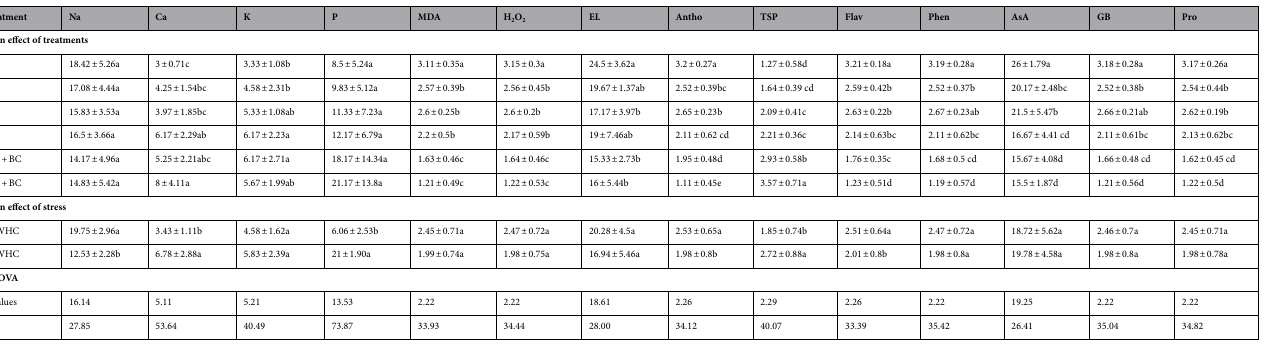
Table 3. Oxidative stress indicators, proteins and ionic contents of wheat plant grown under drought stress conditions after 35 days of seedlings. All values are the means of three replicates ± standard error (SD). Different labels showed significant different alphabets using LSD test. 75 WHC well-watered, 35 WHC drought stress, C control, BR1 1 μmol foliar applied 24-epibrassinolide, BR2 3 μmol foliar applied 24-epibrassinolide, BC timber waste biochar, Na sodium, Ca calcium, K potassium, P phosphorous, MDA malondialdehyde, H 2 O 2 hydrogen peroxide, EL electrolyte leakage, Anth anthocyanin, TSP total soluble proteins, Flav flavonoids,